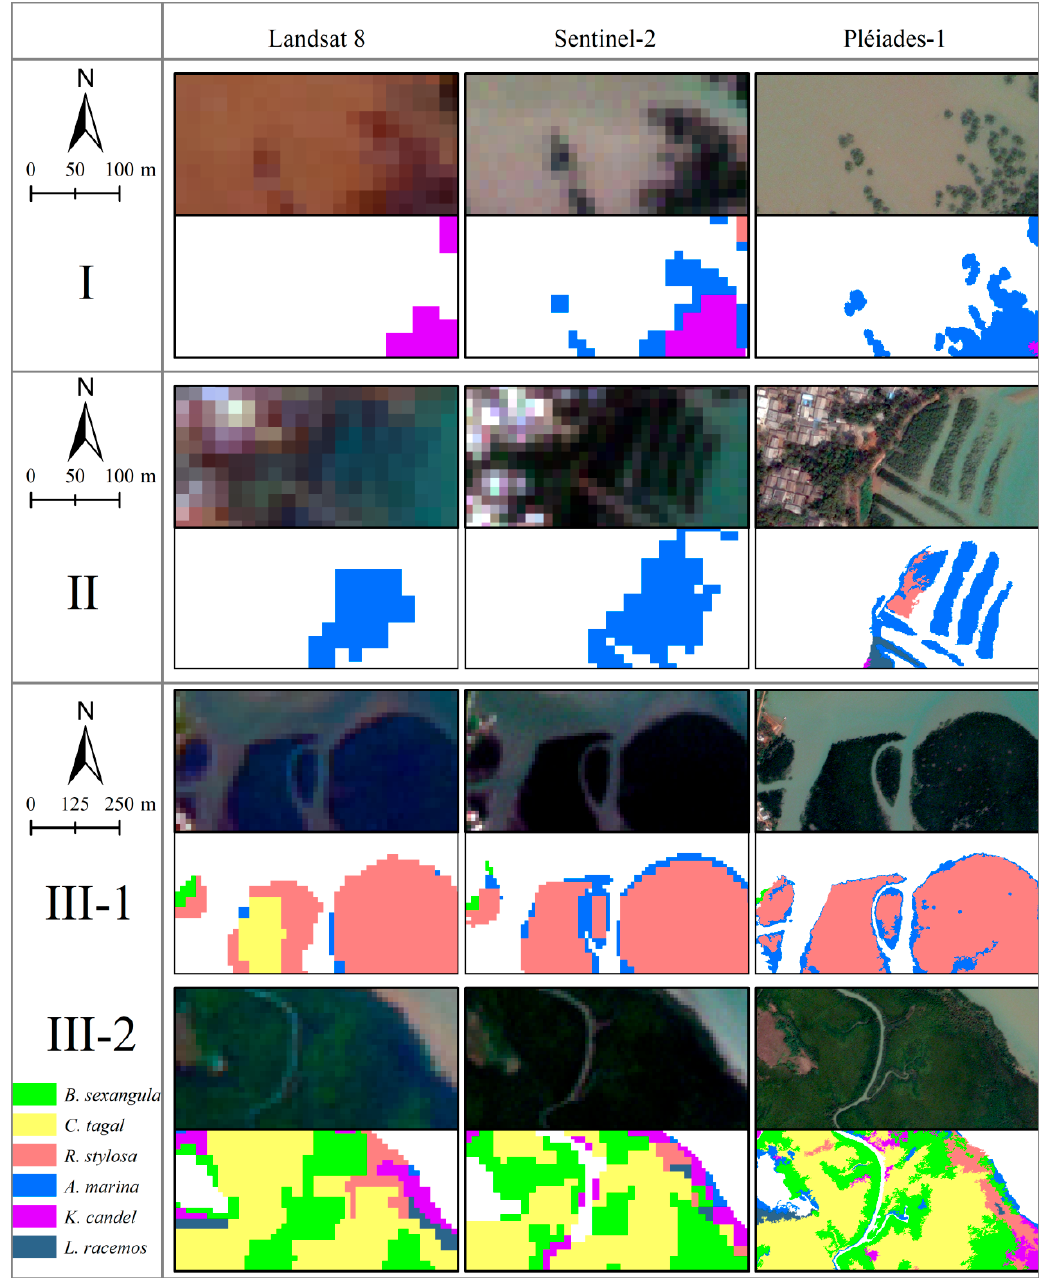
Figure 7. Examples of point (I), line (II) and polygon (III) mangrove classifications using the Landsat 8, Sentinel-2, and Pl é iades-1 imagery in Dongzhaigang. Group III-1 is an area of homogeneous mangrove species communities, and Group III-2 is an area of heterogeneous mangrove species